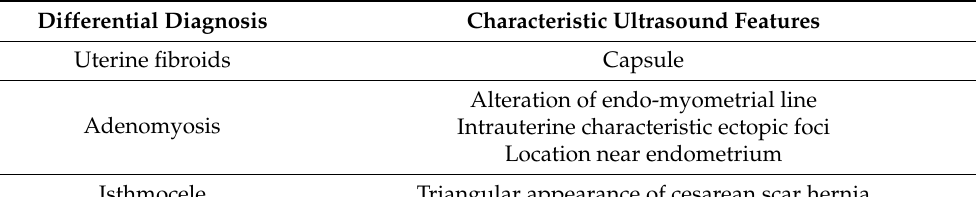
Table 1. Differential diagnosis for heterogenous uterine wall